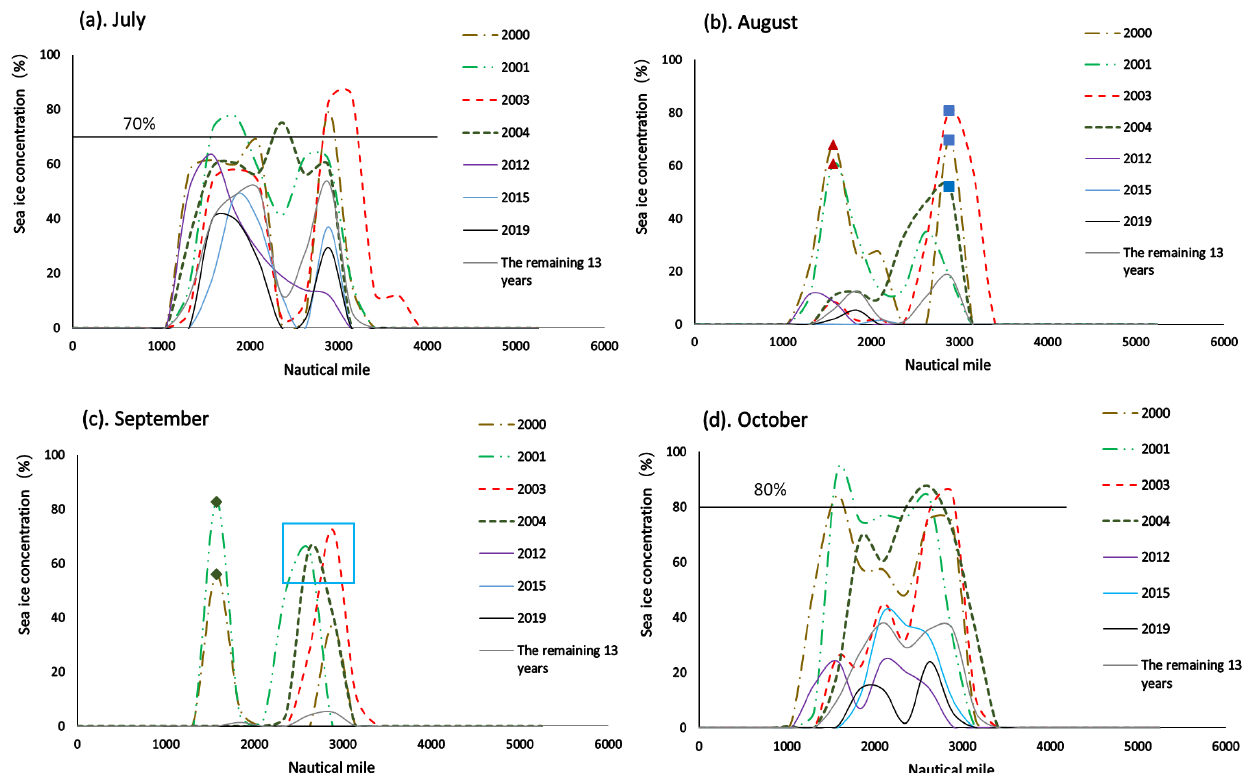
Figure 4. Time-sequence map of monthly average sea ice concentration of the NEP in summer from 2000 to 2019. In ( a ), the 70% line indicates that the peak value of monthly average sea ice concentration in July in 2000, 2001, 2003 and 2004 was respectively above 70%. In ( b ), the red triangles represent that in the East Siberian Sea, the sea ice concentration in 2000 and 2001 were the top two, and the blue squares represent that in the Vilkitsky Strait, the sea ice concentration in 2003, 2000 and 2004 were the top three. In ( c ), the green diamonds represent that in the East Siberia Sea, the sea ice con- centration in 2001 and 2000 were the top two, the blue square represents that in the Vilkitsky Strait, the sea ice concentration in 2001, 2003 and 2004 were the top three. In ( d ), the 80% line in Figure 4 d indicates that the peak value of monthly average sea ice concentration in October in 2000, 2001, 2003 and 2004 was respectively above 80%.